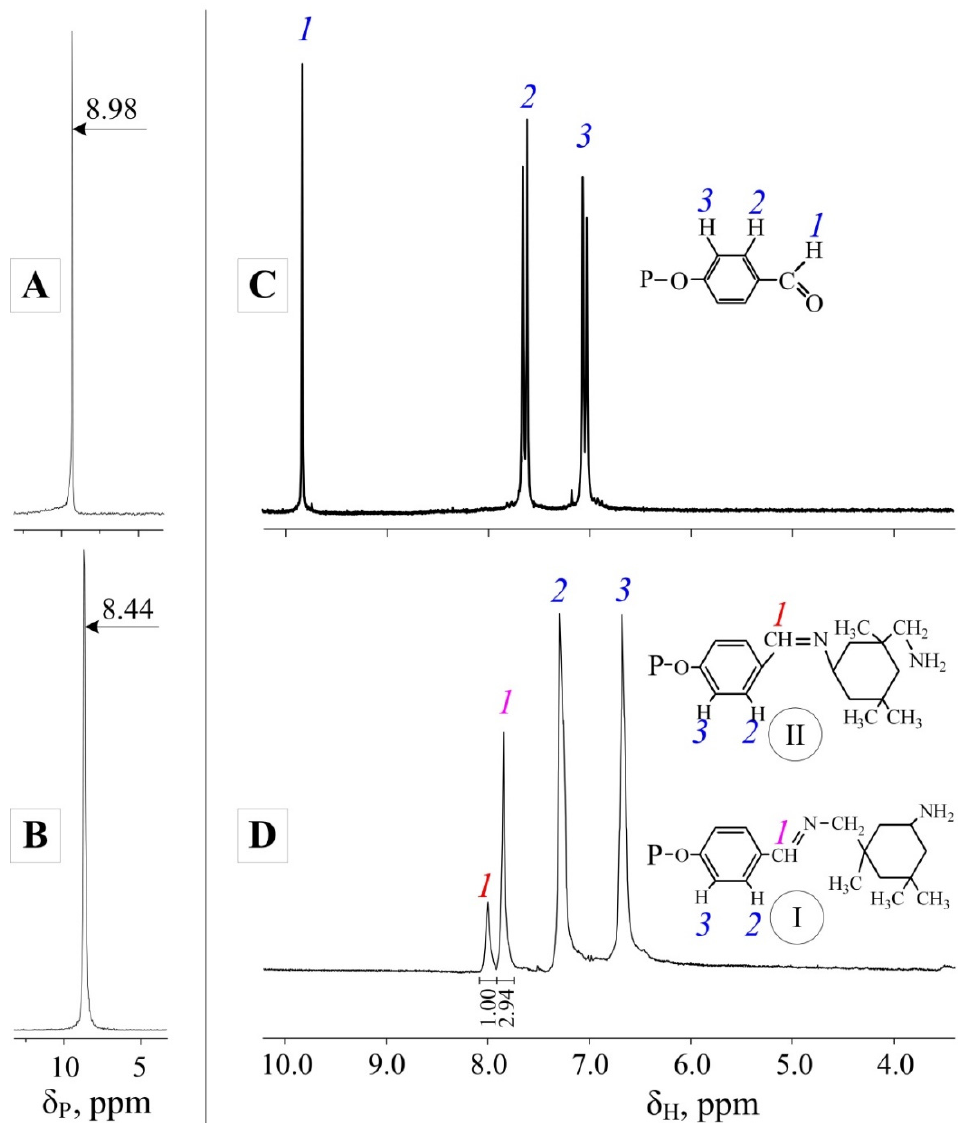
Figure 2. NMR spectra of 31 P FPP ( A ) and its reaction product with IPDA ( B ), and 1 H spectra of FPP ( C ) and its reaction product with IPDA ( D ).